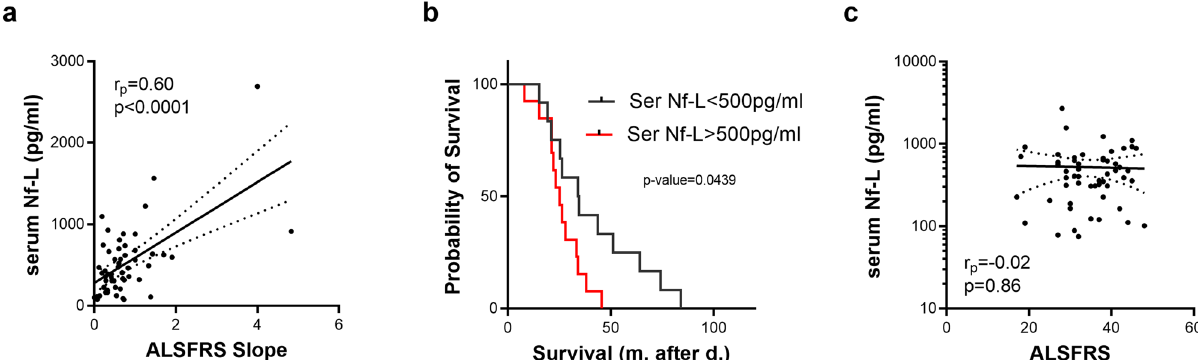
Figure 2. Serum Nf-L association with clinical parameters. Association between Nf-L concentration in serum and clinical parameters ( a : ALSFRS Slope; c : ALSFRS). Kaplan–Meier survival curves of ALS patients according to serum ( b ) Nf-L